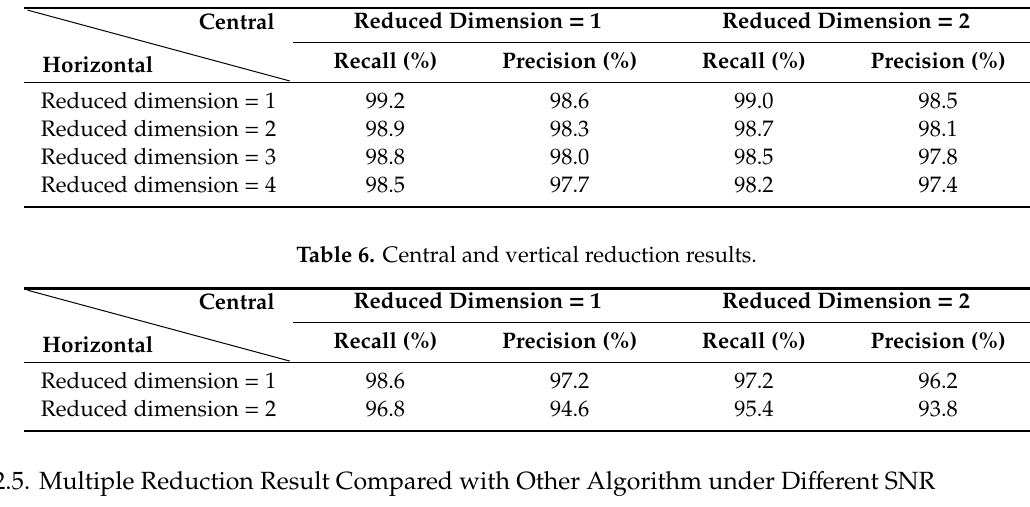
Table 5. Central and horizontal reduction results.